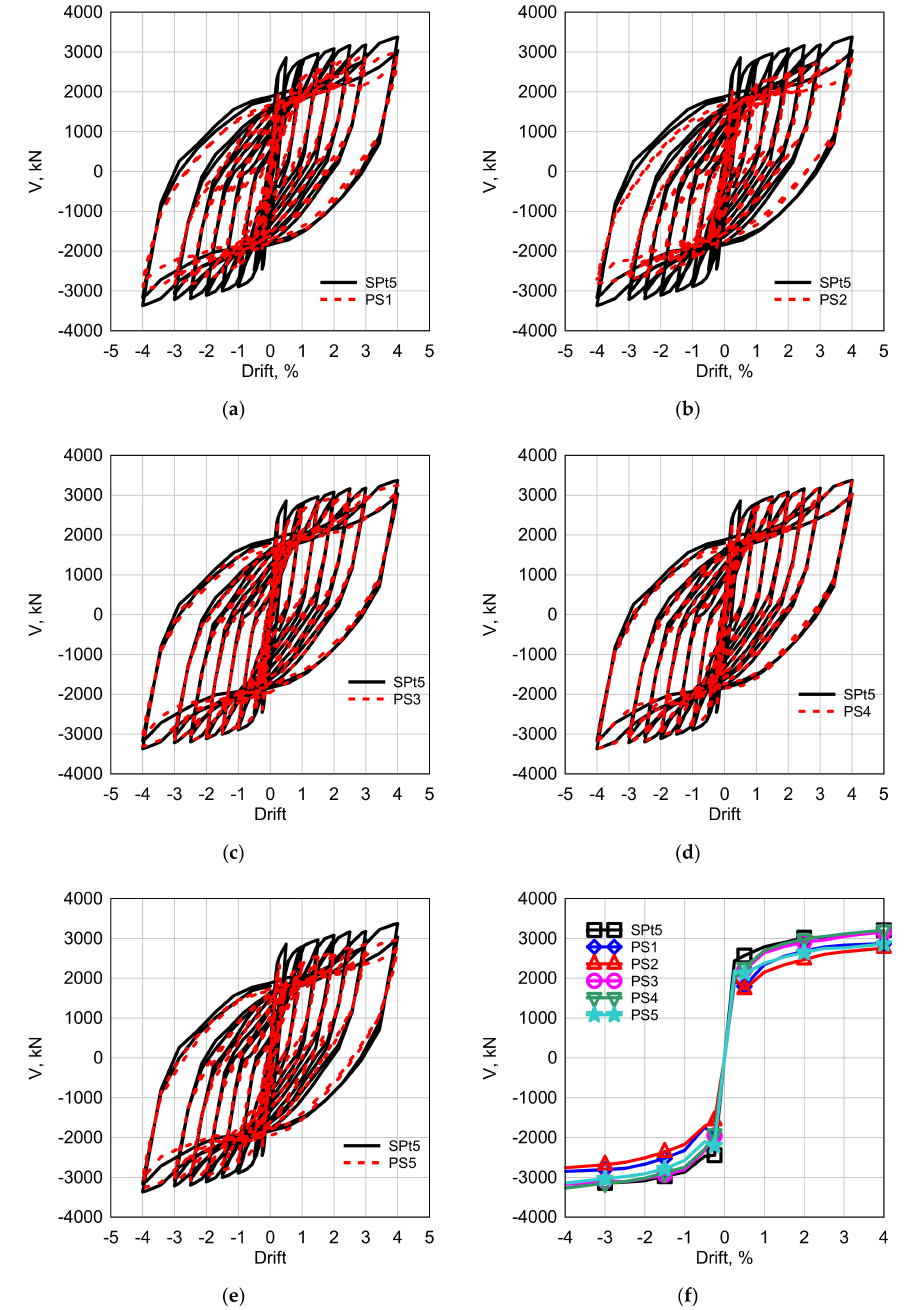
Figure 5. Comparisons between hysteretic and backbone curves; ( a ) SPt5 vs. PS1; ( b ) SPt5 vs. PS2; ( c ) SPt5 vs. PS3; ( d ) SPt5 vs. PS4; ( e ) SPt5 vs. PS5; ( f ) backbone